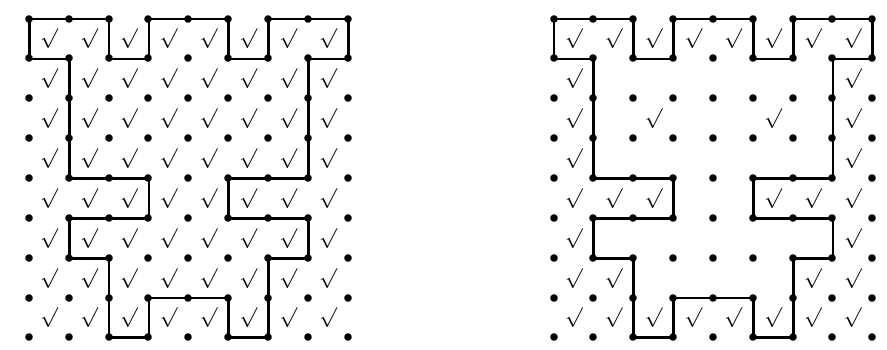
Figure 9. Input of Slitherlink generation; example #2.